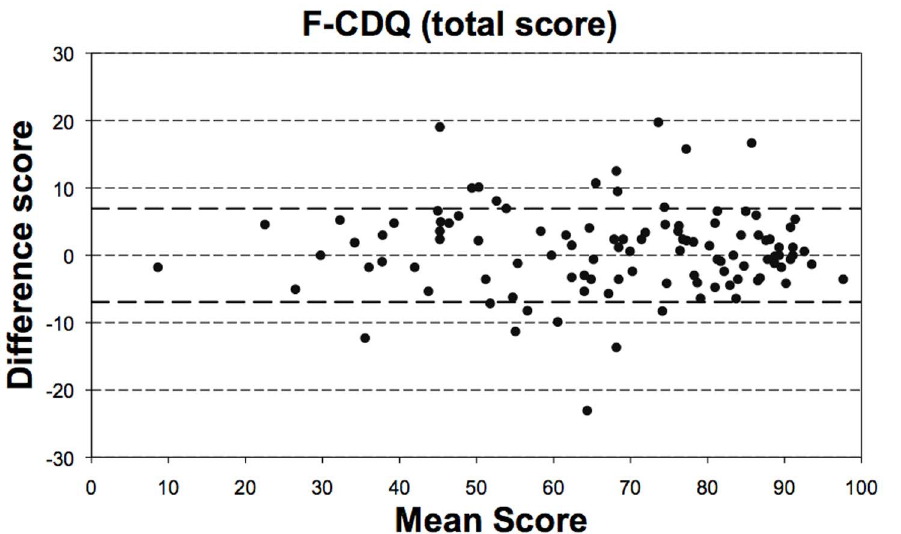
Figure 1. Bland and Altman graphical analysis of the reproducibility of the total score of the French version of the ‘‘Celiac Disease Questionnaire’’ (F-CDQ). Mean total score of the two F-CDQ assessments (baseline and retest 7 days later for patients who stated that their health status was unchanged) plotted against the difference of these two measures. The horizontal dotted lines indicate the mean difference 6 1 SD.